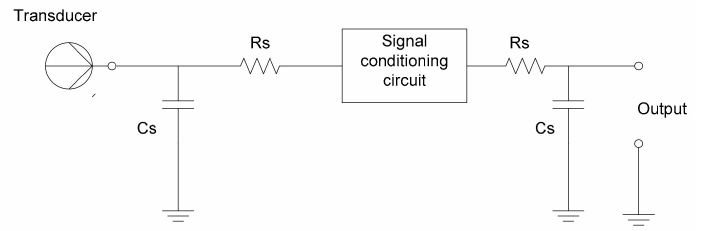
Figure 3. Passive resistive-capacitive (RC) protective circuitry for static electrical discharges.